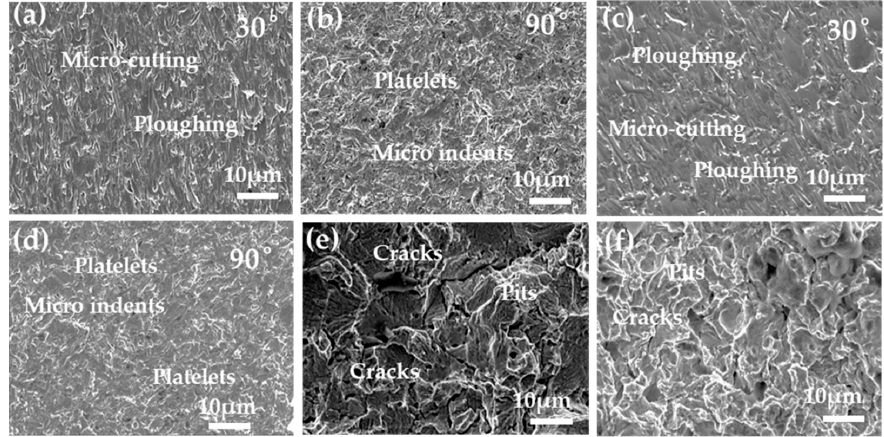
Figure 20. Scanning electron microscope images showing the damage mechanism due to slurry erosion of ( a , b ) stainless steel 316L and ( c , d ) Al 0.1 CrCoFeNi high entropy alloy at different impingement angles. SEM images of cavitation eroded ( e ) SS316L steel and ( f ) Al 0.1 CrCoFeNi CCA samples tested for 20 h [26,76] (reprinted with permission from Elsevier and Wiley).